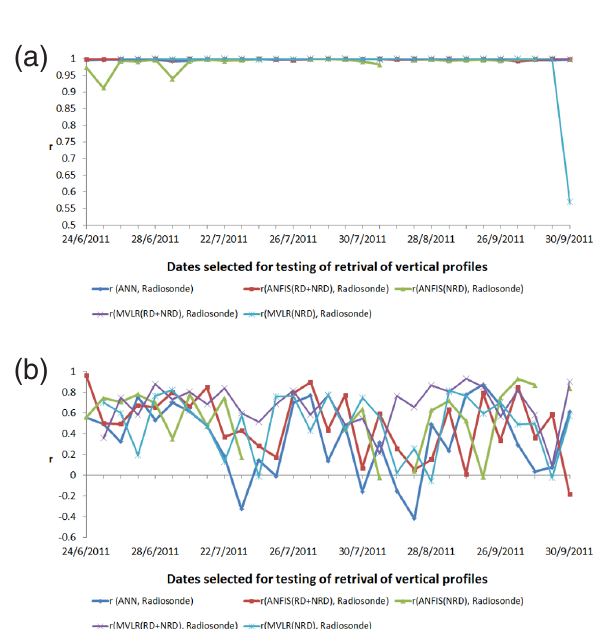
Figure 4. Pearson product movement correlation coefficient ( r ) be- tween radiosonde (a) temperature and (b) humidity profiles with retrieved profiles using ANN, ANFIS(RD + NRD), ANFIS(NRD), MVLR(RD + NRD) and